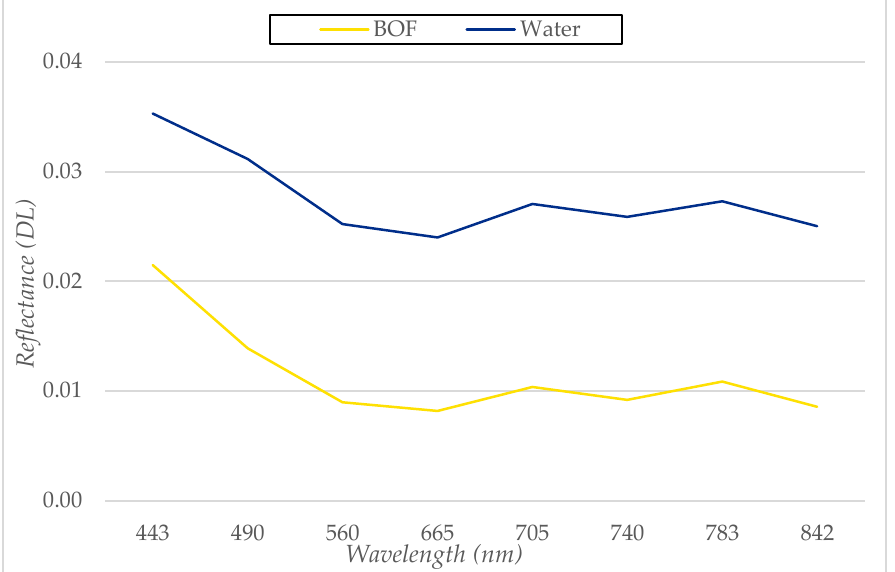
Figure 5. Spectral signatures of Biogenic Oil Film (BOF) and water. The reflectance is dimensionless (DL) and the wavelength is measured in nanometers (nm). The application of the adaptive threshold led to binary images (dark spot masks) 205 with a value of 1 for the dark spots detected and 0 for the other pixels ( Error! Reference 206 source not found. ). The masks were afterward converted from raster to polygons using a 207 raster-to-vector algorithm, and the polygons were smoothed to avoid complicated shapes. The attribute table of the objects was enriched with information about their size and shape.